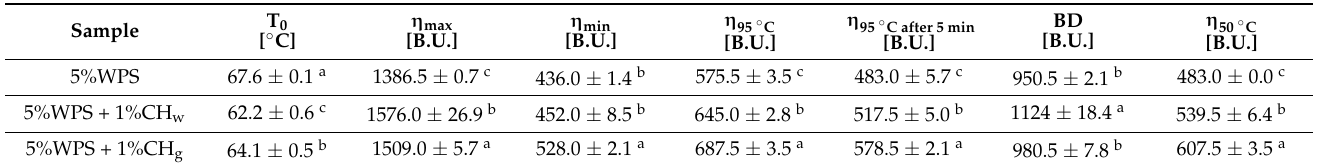
Table 2. Pasting characteristics of 5% WPS and WPS with an addition of 1% of CH (whole and ground seeds).